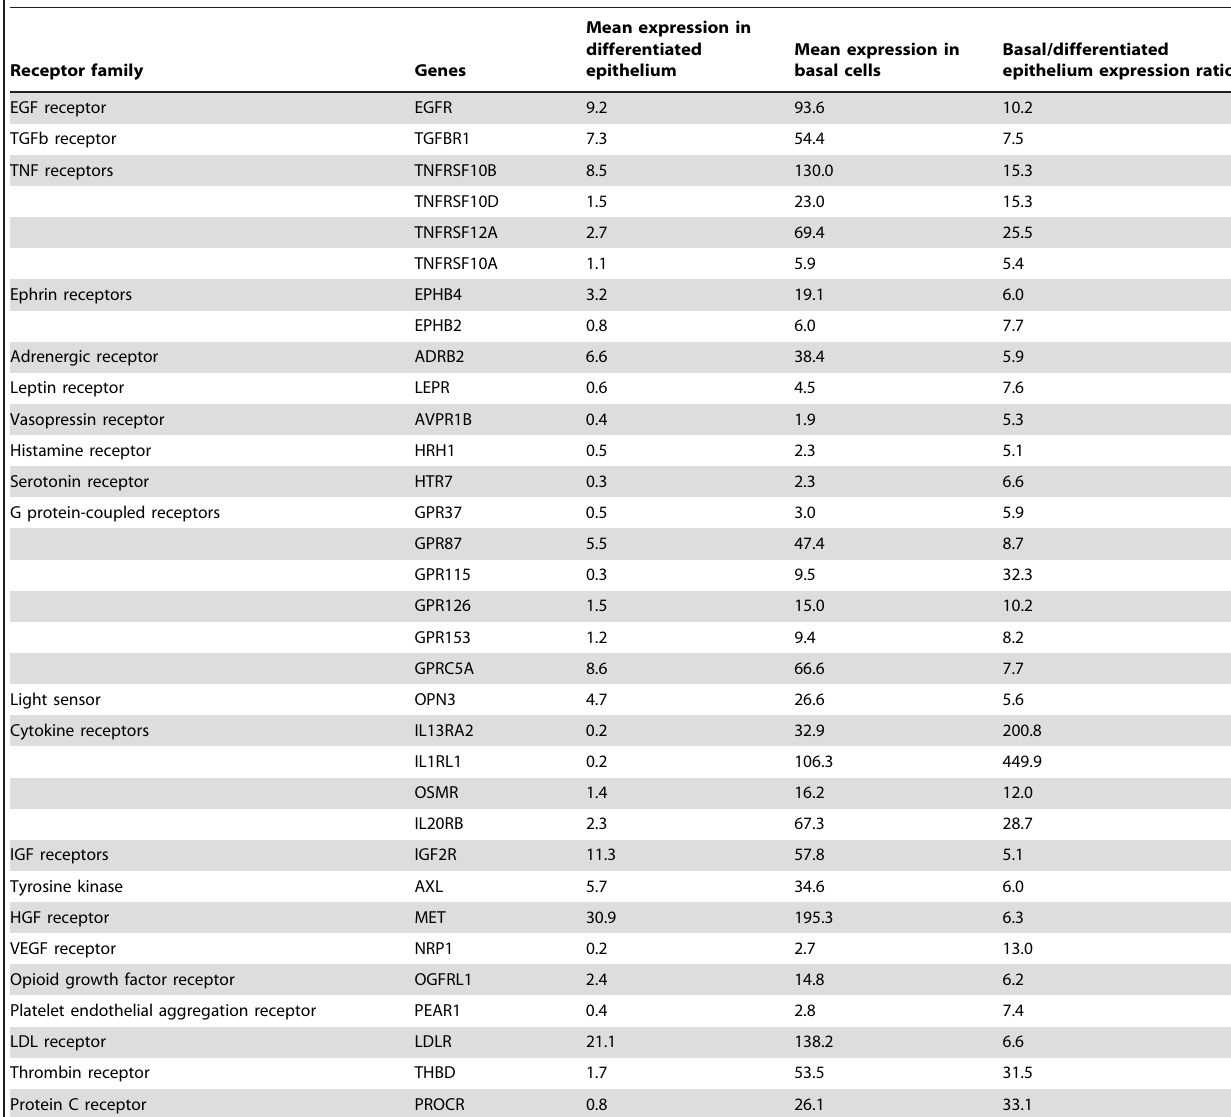
1 Genes identified by GATHER KEGG categories (Table 2, Table S3), Gene Ontology categories (Table 3, Table S5) and/or Canonical Pathways (Table 4, Table S6).